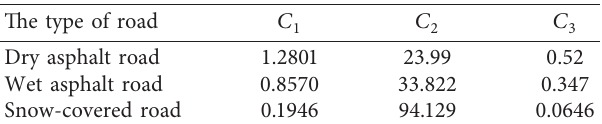
Figure 7: The relationship between braking force coefficient and wheel slip rate. Table 1: The value of C